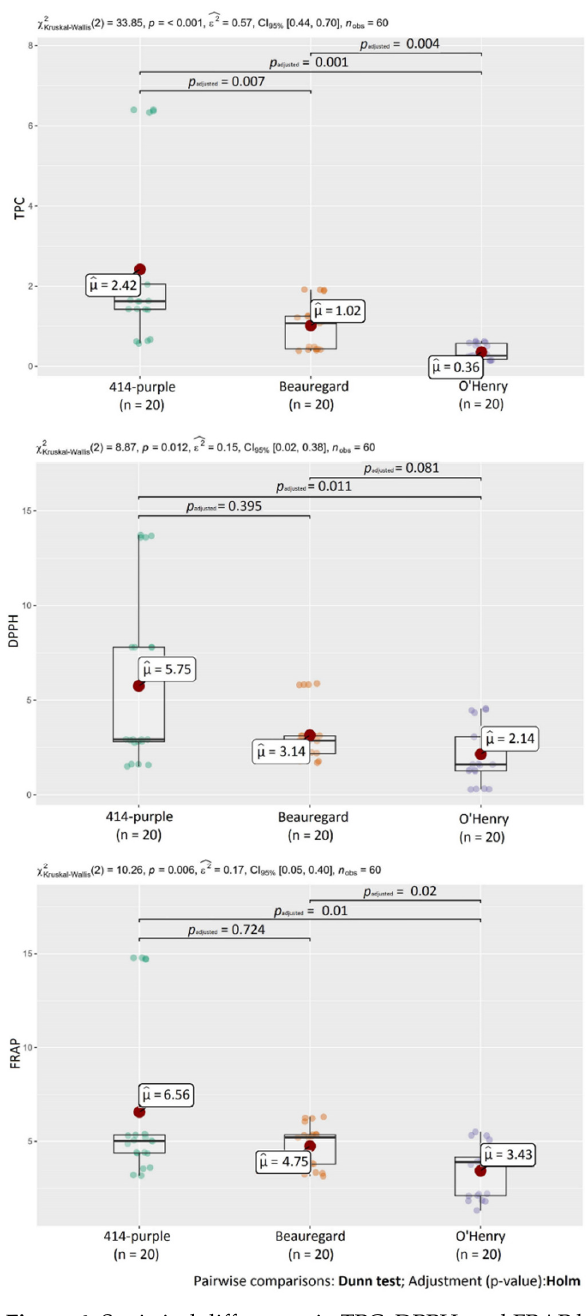
Figure 6. Statistical differences in TPC, DPPH, and FRAP between monitored SP varieties.